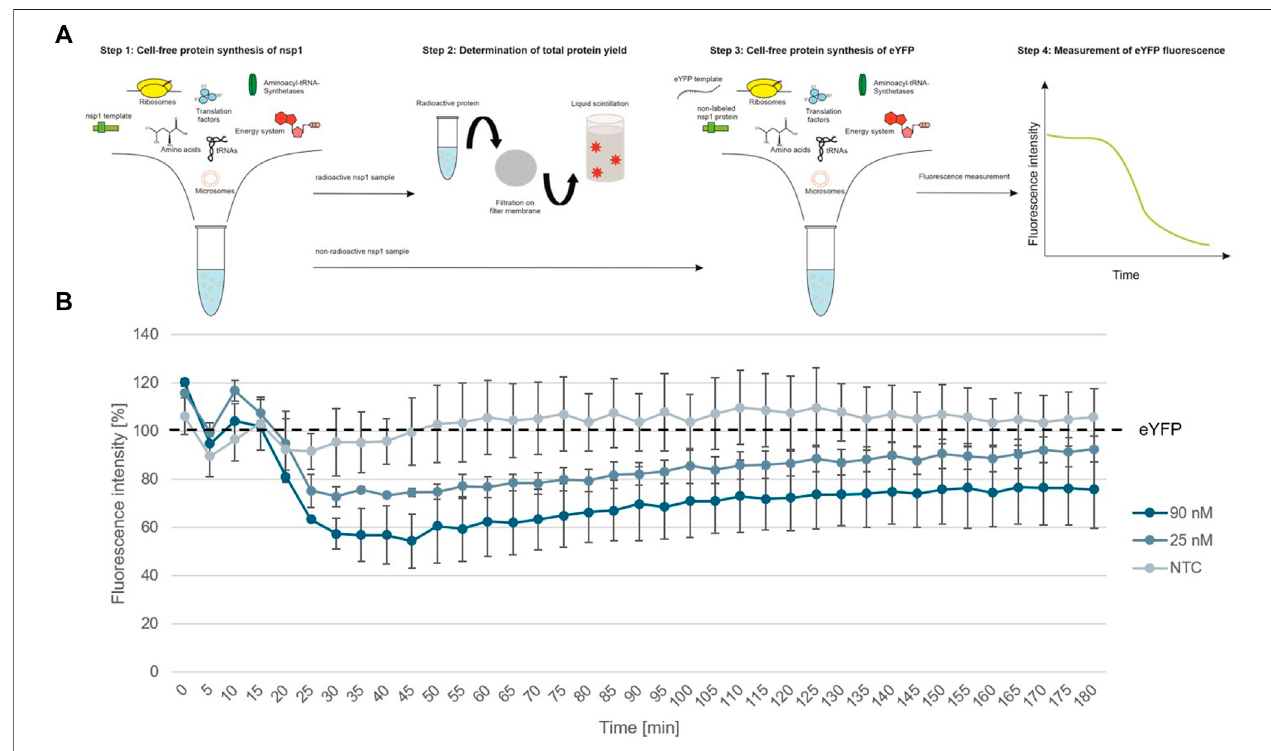
FIGURE3| Functionalanalysisofnsp1. (A) Schematicschemeofnsp1functionalityassay. (B) Applicationofcell-freesynthesizednsp1at90and25 nMtothecell- free protein synthesis of the model protein eYFP. Data were normalized to eYFP fl uorescence signal. Standard deviation was calculated from two experiments.